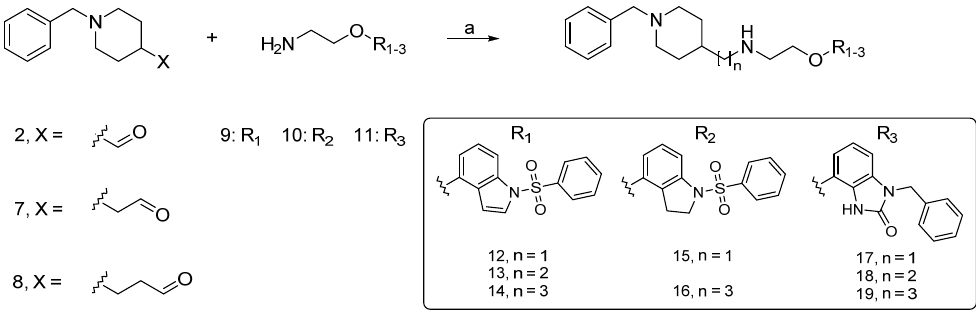
Table 1. Affinity for 5-HT 6 R and inhibition of h AChE and h BuChE by compounds 12 – 19 . Cmpd.